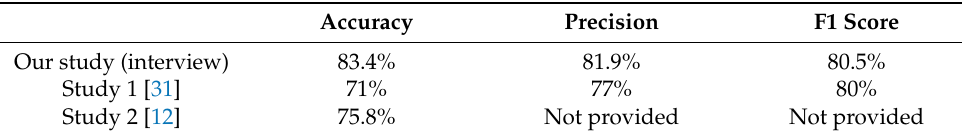
Table 4. Comparison of the results of similar